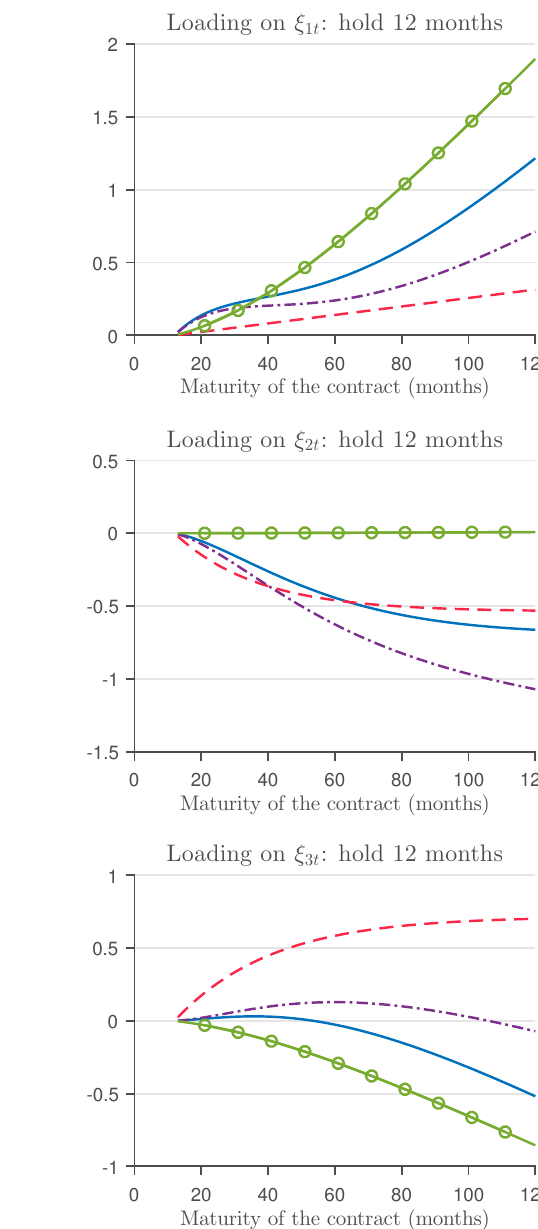
Figure 3. Loadings on factors: one-month and one-year excess holding